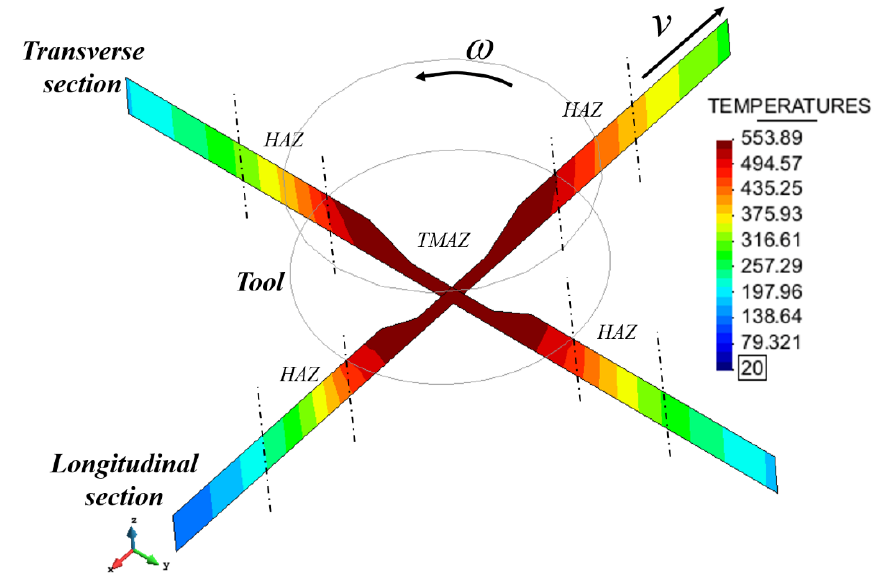
Figure 9. Temperature distribution in the transverse and the longitudinal cross-sections of the welds .